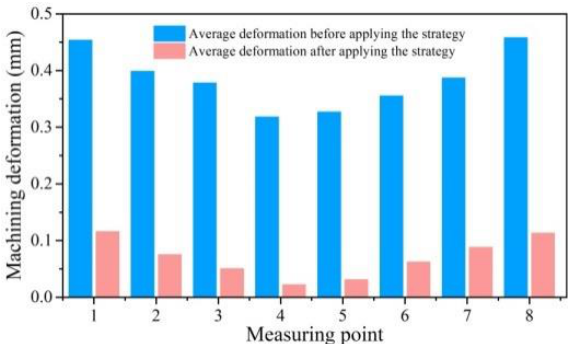
Figure 12. Distribution of deformation monitoring points.